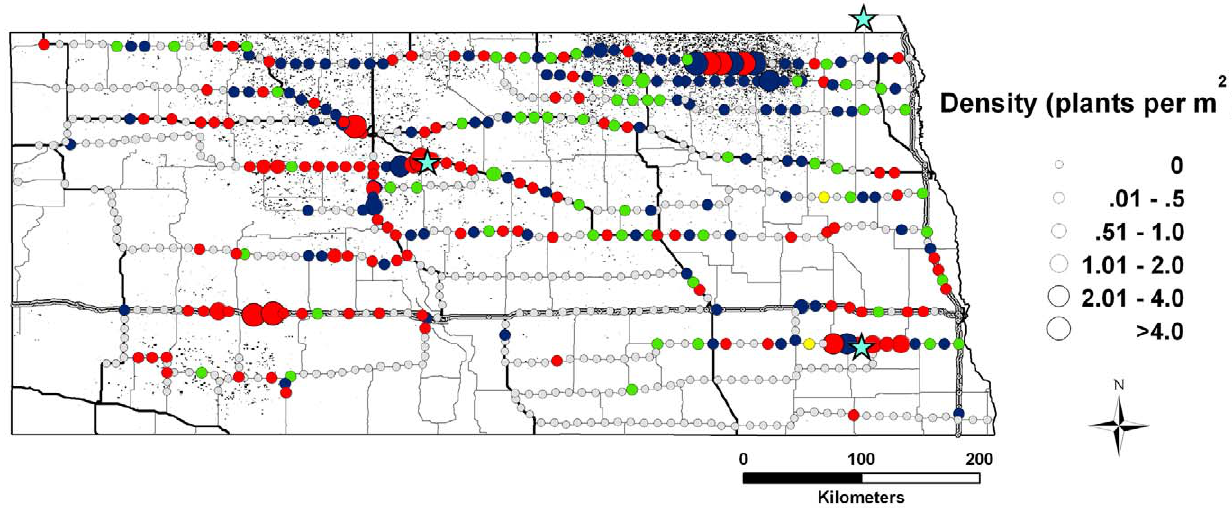
Figure 1. Distribution and density of feral canola populations in North Dakota road surveys (2010). Circles indicate locations of sampling sites; diameter of circle indicates plant density; gray circles indicate no canola present. The presence of genetically engineered protein in the vouchered specimen is shown by color: red – glyphosate resistance; blue – glufosinate resistance; yellow – dual resistance traits; green – non- transgenic. Canola fields are indicated by stippling based on 2009 USDA National Agricultural Statistics Service report